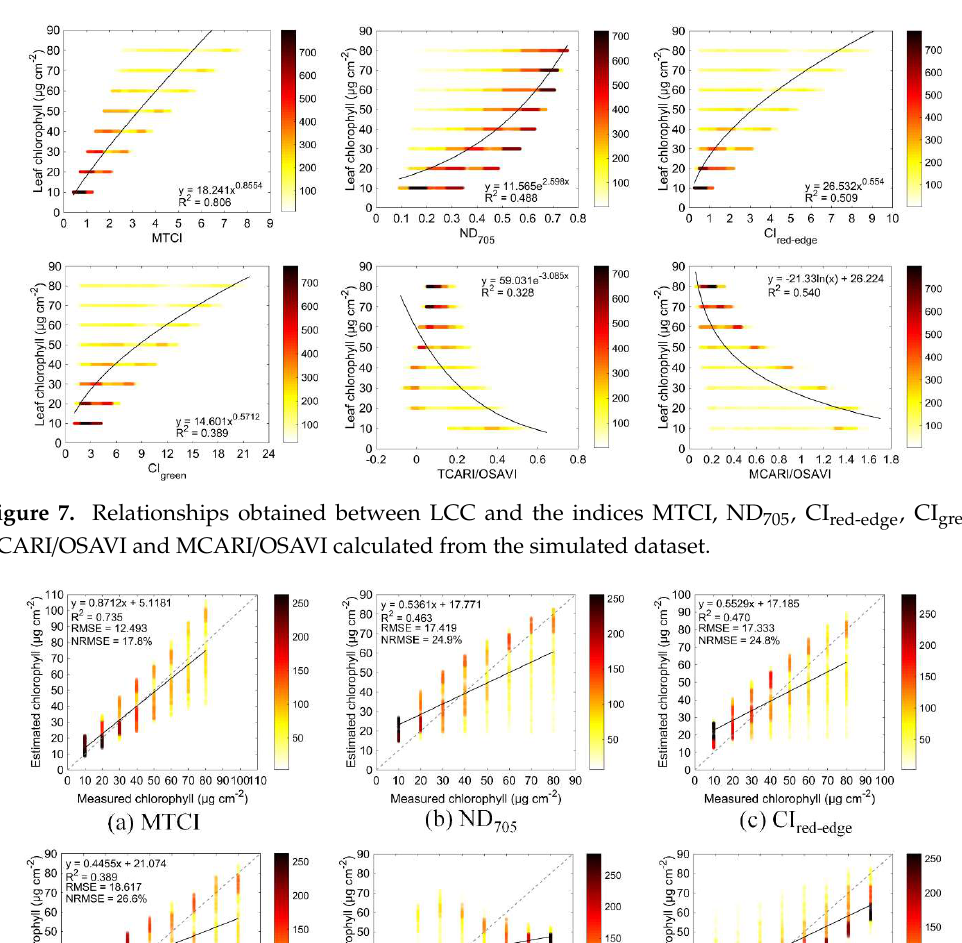
Figure 6. LCC retrieval performance using the LUT approach with the simulated dataset for: ( a ) MERIS; and ( b ) OLCI. Darker colors indicate higher dot density.